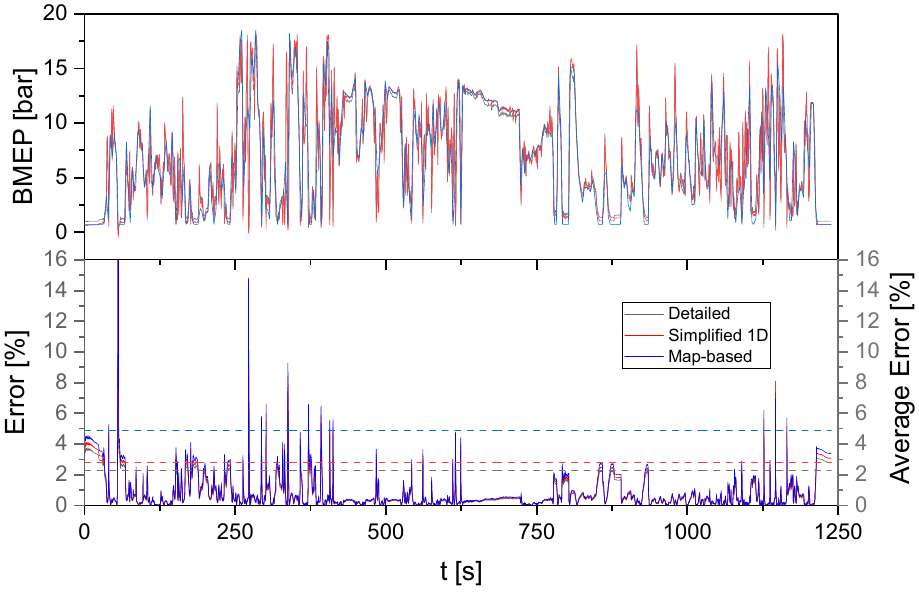
Figure 9. BMEP comparison.